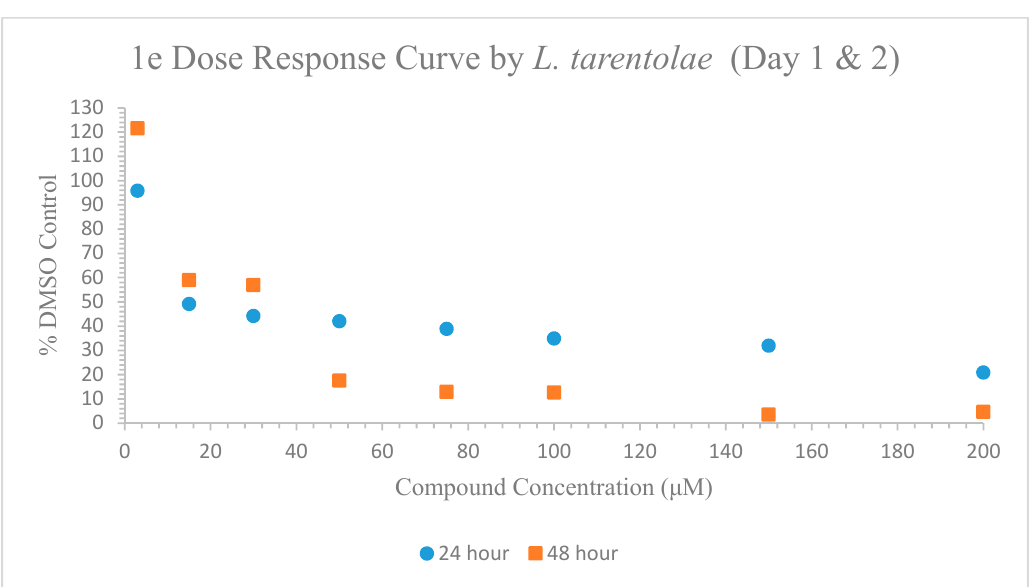
Figure 8. The dose-response curve at 24 and 48 h after a single addition of test compound 1e at concentrations ranging from 4.5 to 200 µM.